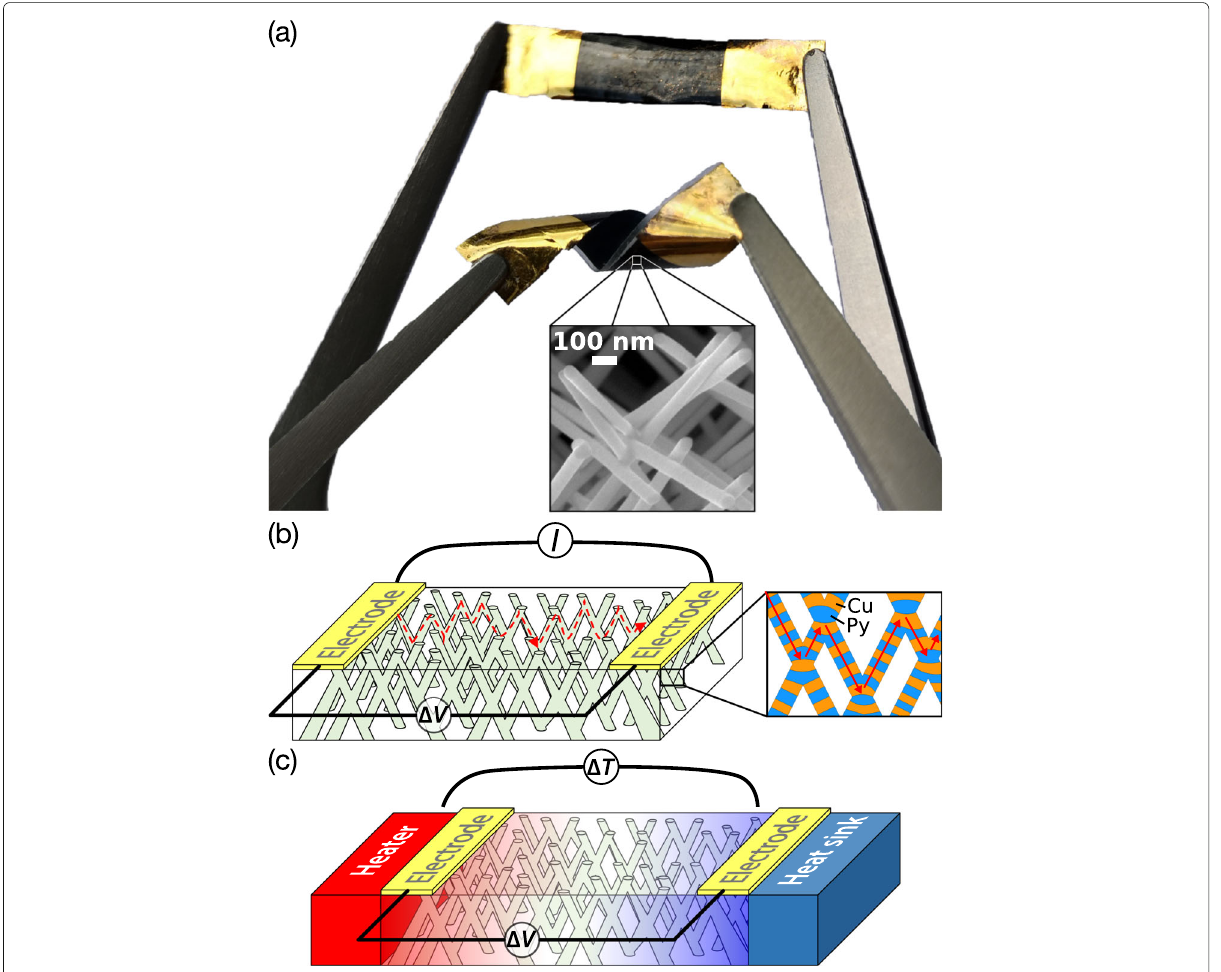
Fig. 1 a Photograph of a flexible spin caloritronic device based on a nanowire network. The inset SEM image shows the nanowire branched structure with diameter of ∼ 80 nm. Schematic representation of an electrode design for electrical ( b ) and thermoelectric ( c ) measurements of an interconnected NW network. The inset of Fig. 1b shows a schematic drawing of the Py/Cu multilayer structure. Red arrows represent the direction of current flow. The color in c represents the generated temperature profile in the NW networks